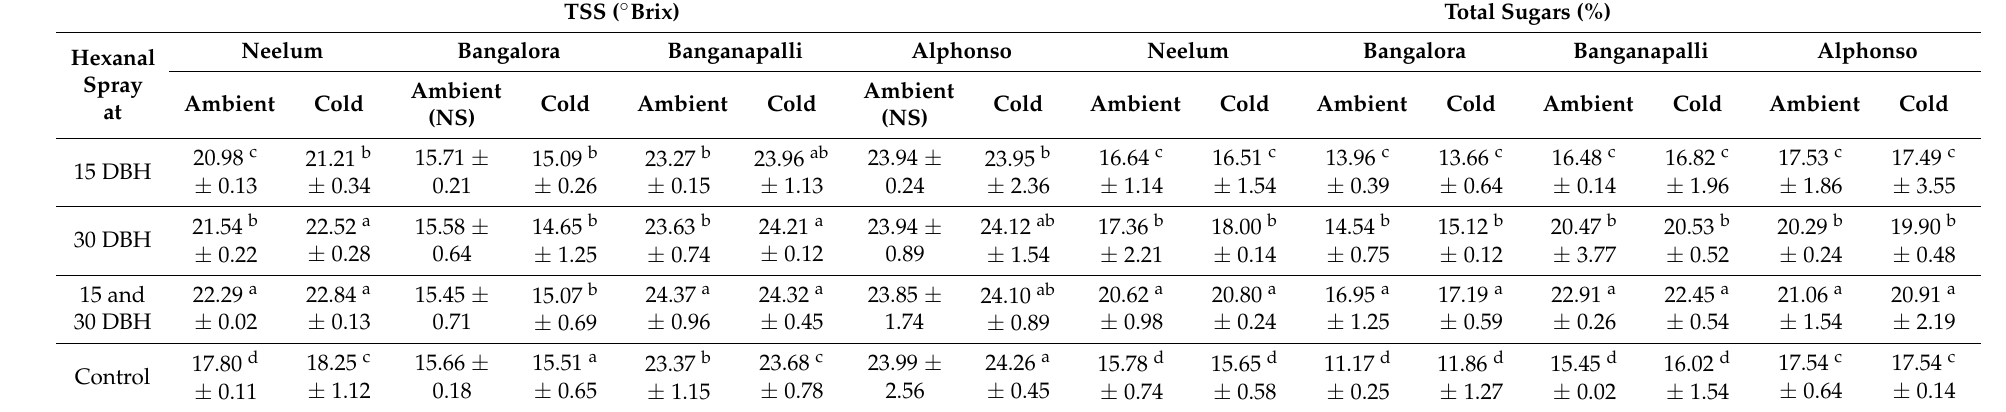
Table 2. Influence of the hexanal formulation on the TSS and total sugars of mango cultivars under ambient and cold storage conditions. TSS ( ◦ Brix) Total Sugars (%)